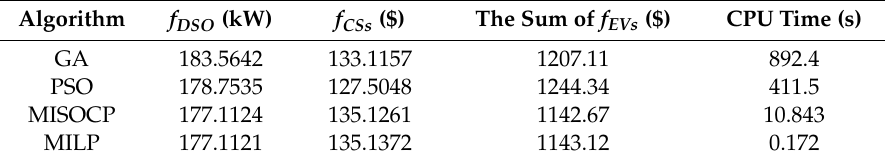
Table 1. Comparisons of calculation